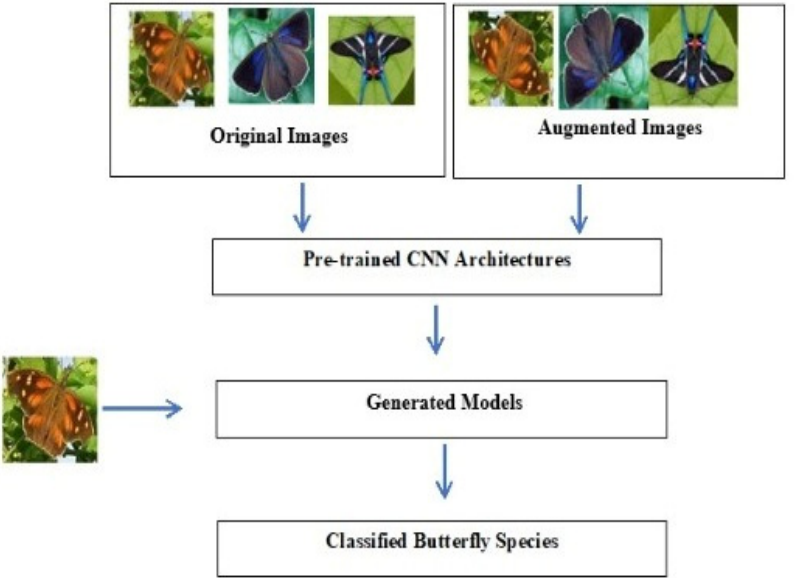
Figure 2. The proposed system’s workflow .